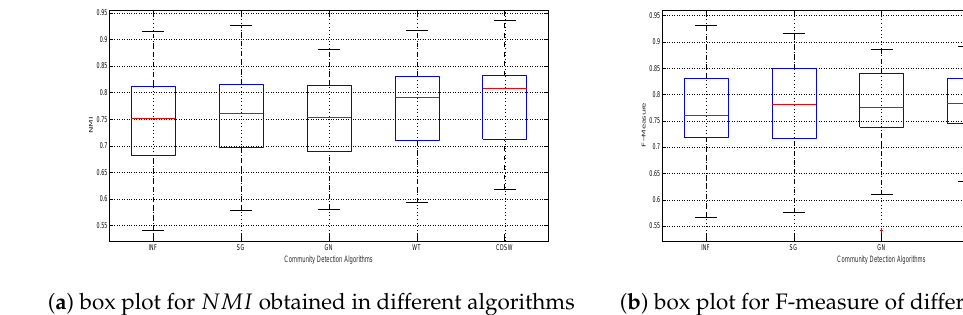
( b ) box plot for F-measure of different algorithms